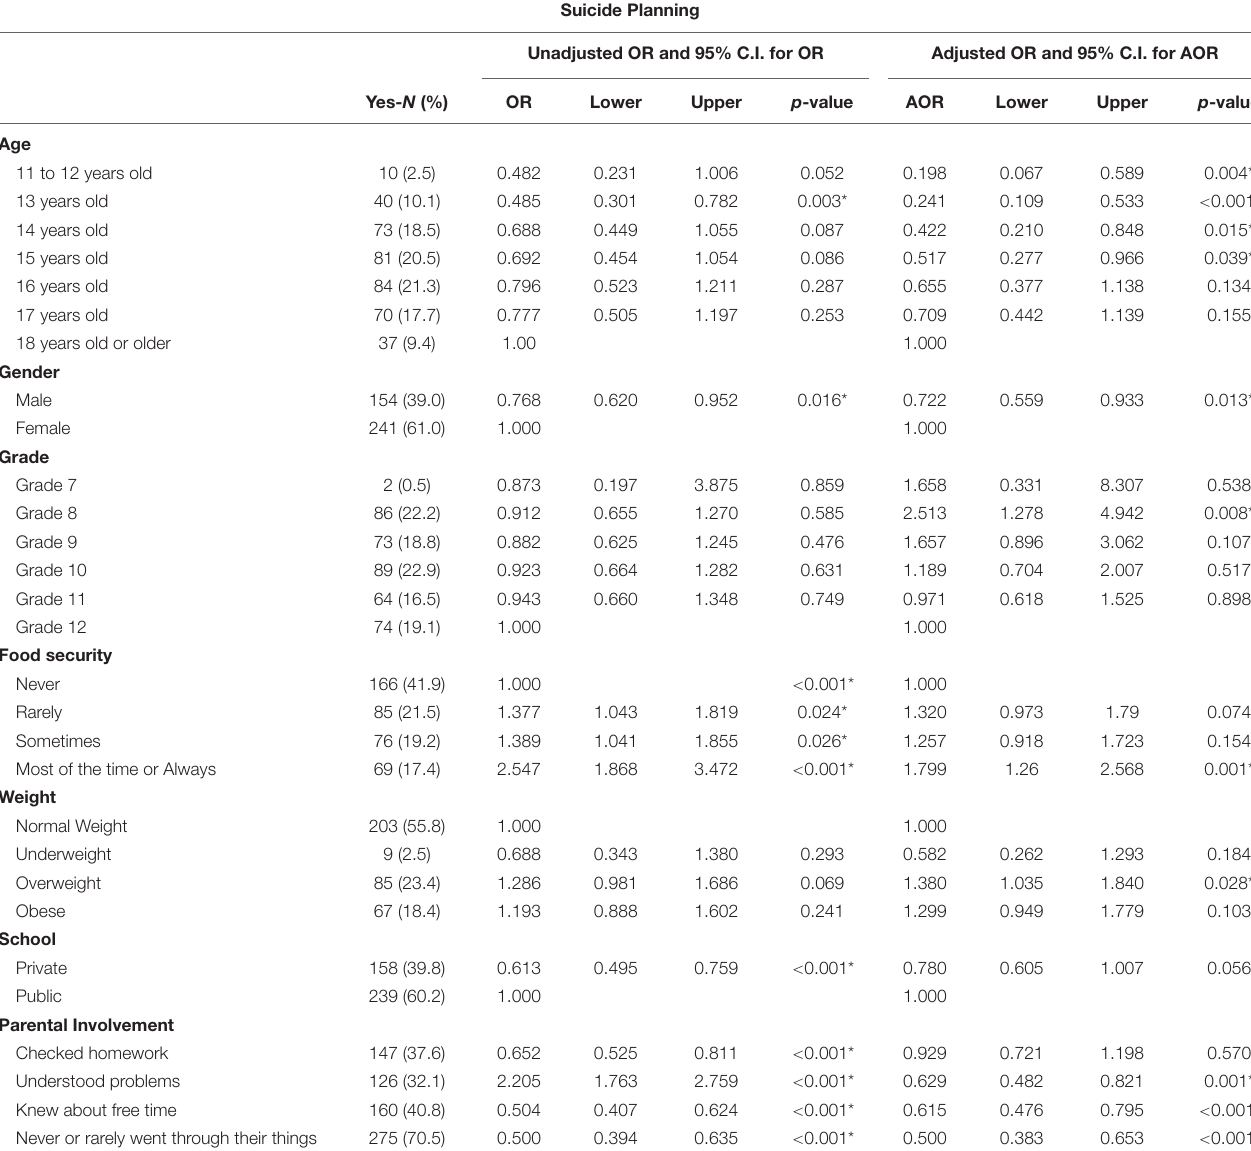
TABLE 3 | Bivariate and multivariate results of the association between suicide planning and weight category with other demographics of participants. Suicide Planning Unadjusted OR and 95% C.I. for OR Adjusted OR and 95% C.I. for